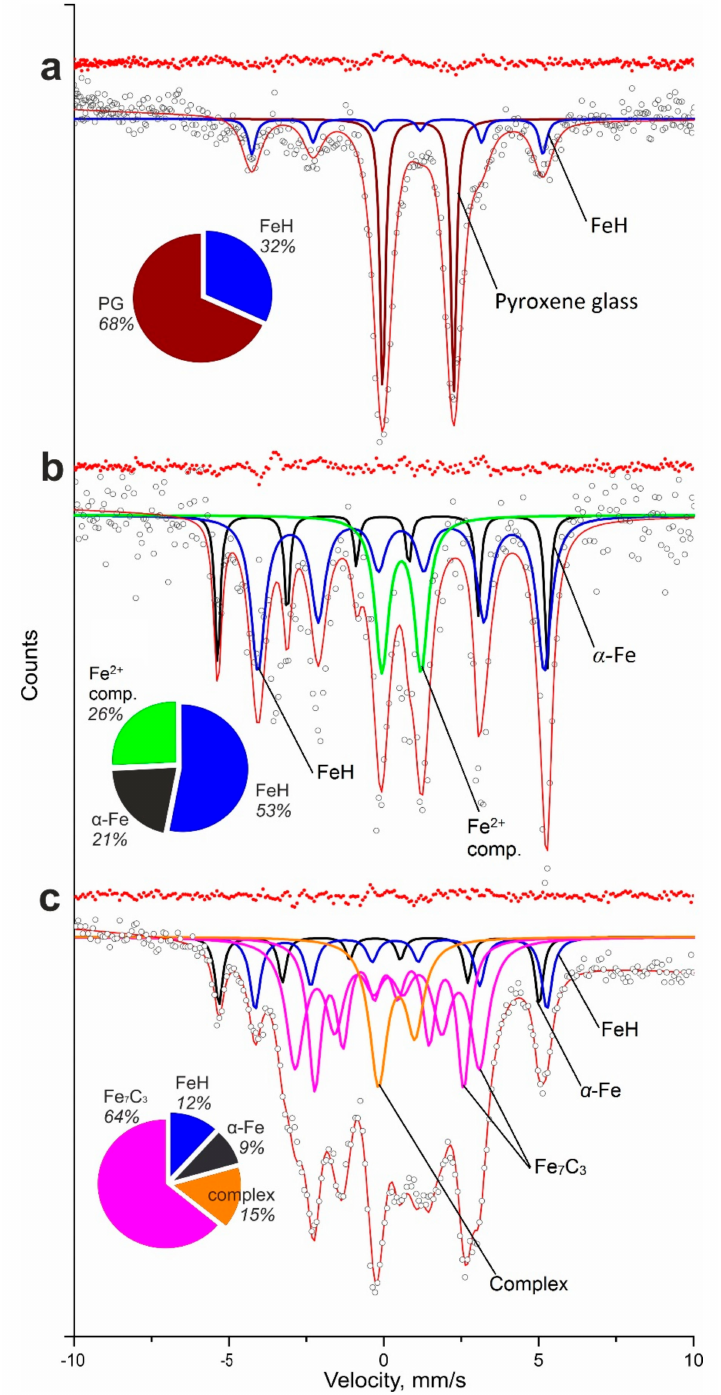
Figure 2. Examples of Mössbauer spectra collected at high pressure after quenching from high temperature. The following mixtures of hydrocarbons and Fe 2 + -bearing materials were heated: ( a ) Pyroxene-like glass (PG) (Mg 0.91 Fe 0.09 )(Si 0.91 Al 0.09 )O 3 and para ffi n oil heated at 4.5(0.2) GPa and 1800(100) K, ( b ) ferropericlase (Mg 0.8 Fe 0.2 )O and crude oil at 6.9(0.2) GPa and 1800(100) K, ( c ) iron oxide (II) Fe 0.94 O and para ffi n oil at 7.5(0.2) GPa and 1600(100) K. Experimental points are shown by dots, fits by red lines, residuals are shown above each spectrum, and percentage sections indicate the relative amount of each component. Hyperfine parameters are given in Table